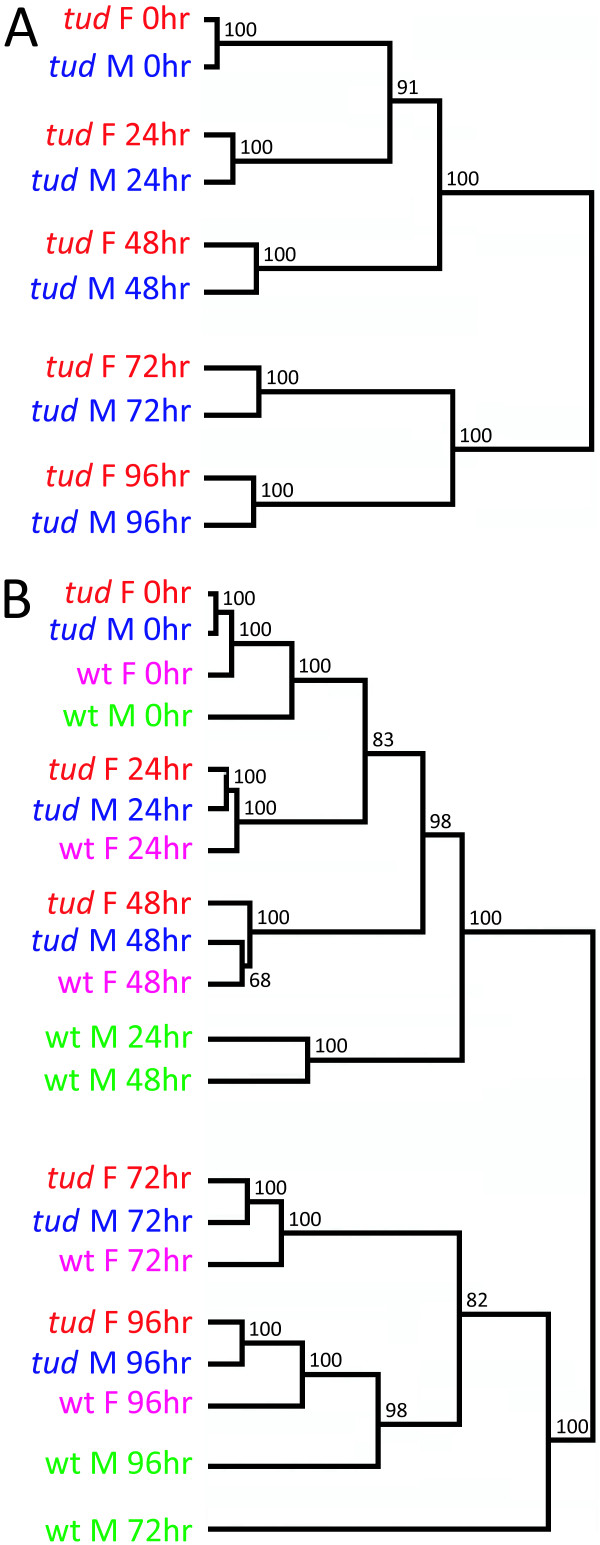
Cluster of global expression profiles for Drosophila transcripts across metamorphosis. Dendrogram shows the similarity across transcriptional profiles at five time points during metamorphosis (0, 24, 48, 72, and 96 hour APF) for (A) male tud progeny (blue) and female tud progeny (red) and (B) male tud progeny, female tud progeny, wild type (CS) males (green), and wild type (CS) females (violet). Hierarchical clustering and Pearson correlation distance measure was used to group experiments based on their global expression profile using all expression data for annotated genes from each array. Values on each node represent the confidence of the separation (approximately unbiased P value) derived using multiscale bootstrap resampling and the program Pvclust [63].